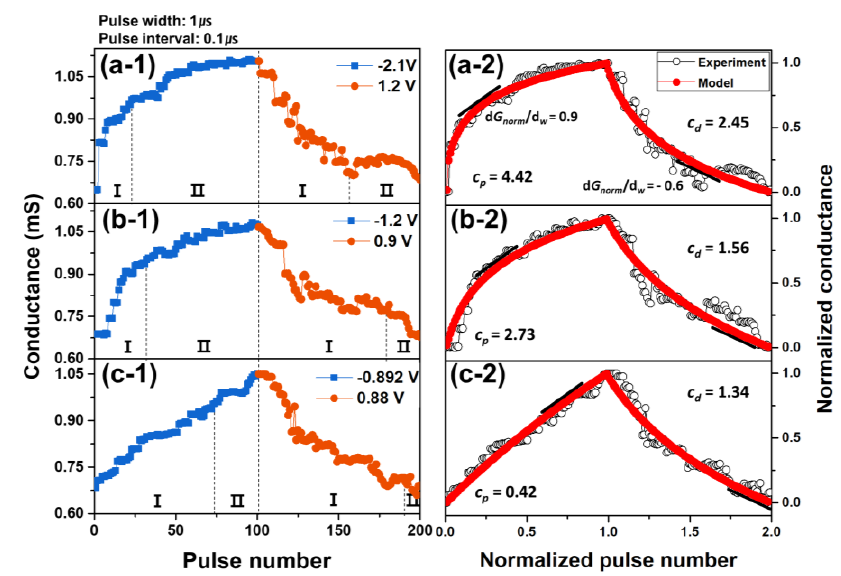
Figure 5. Variation of conductance with the applications of 100 P-spikes and 100 D-spikes to the PCMO memristor grown under various Ops: ( a-1 ) 300 mTorr, ( b-1 ) 200 mTorr, and ( c-1 ) 100 mTorr. Potentiation and depression curves with c p and c d values for the PCMO memristor grown under various Ops: ( a-2 ) 300 mTorr, ( b-2 ) 200 mTorr, and ( c-2 ) 100 mTorr.